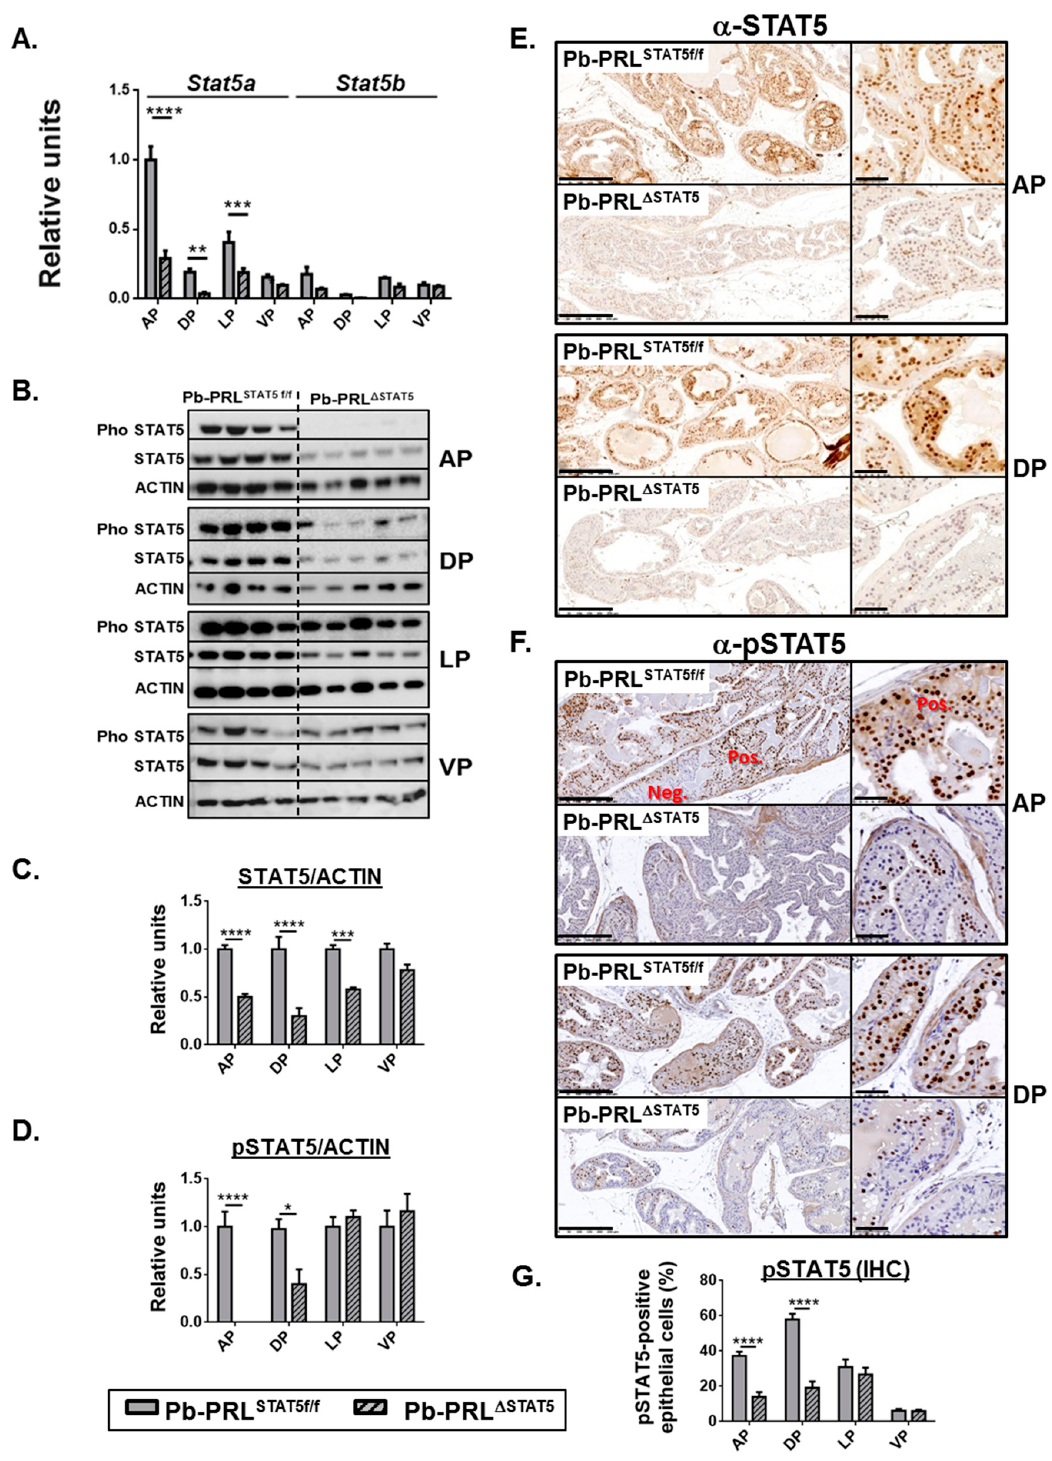
Figure 1. Lobe-specific pattern of STAT5 deletion in 6 month-old Pb-PRL ∆ STAT5 mice. ( A ). Lobe-specific expression of Stat5a and Stat5b mRNA in Pb-PRL STAT5f / f and Pb-PRL ∆ STAT5 mice as determined by RT-qPCR is shown. ( B – D ). Lobe-specific expression and phosphorylation of STAT5 protein in Pb-PRL STAT5f / f and Pb-PRL ∆ STAT5 mice as determined by immunoblot is shown. Quantification of STAT5 / ACTIN (C) and pSTAT5 / ACTIN (D) was performed by densitometry and is shown as fold change versus Pb-PRL STAT5f / f mice for each lobe. ( E , F ). Immunohistochemical analysis of STAT5 protein expression ( E ) and phosphorylation ( F ) in anterior (AP) and dorsal (DP) prostates of Pb-PRL STAT5f / f and Pb-PRL ∆ STAT5 mice, as indicated. In panel F, negatively (neg) next to positively (pos)